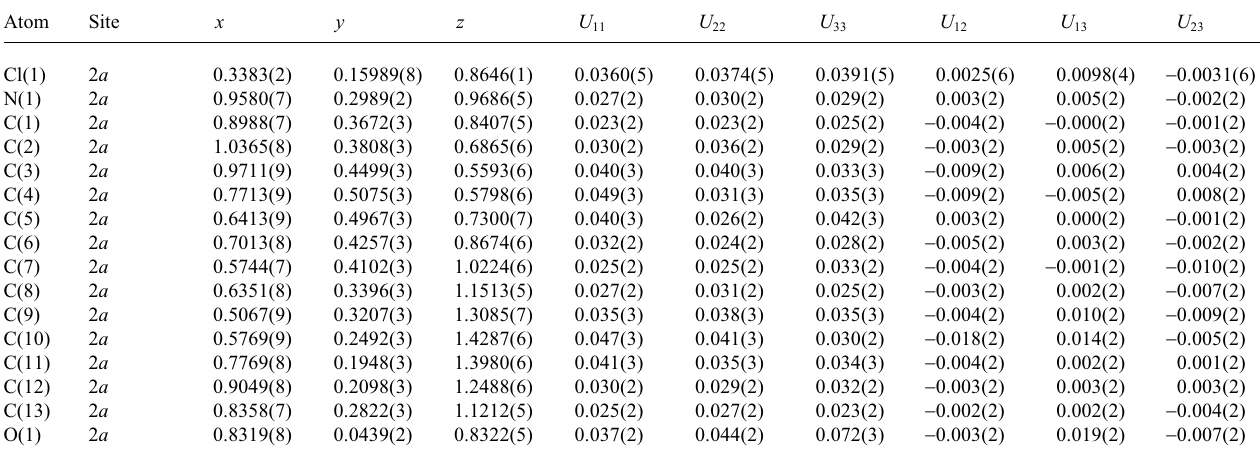
Table 3. Atomic coordinates and displacement parameters (in Å 2